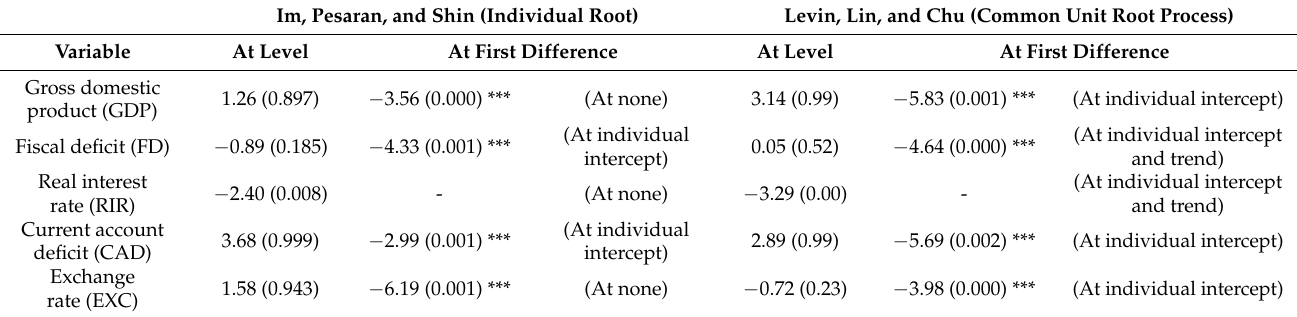
Table 5. Findings of panel unit root testing for lower-middle-income economies (LMIE).